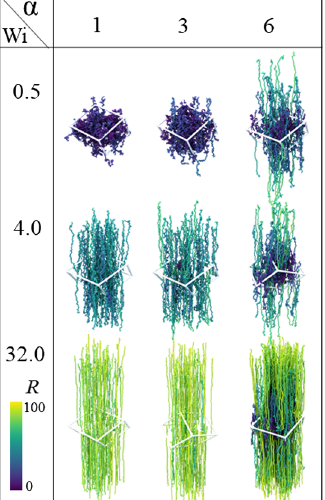
FIG. 1. Snapshots illustrating chain stretching for associating group strength α ¼ 1 , 3, and 6 for Wi ¼ 0 . 5 , 4, and 32 at strain ε ¼ 10 . For clarity, 1 = 4 of systems are shown. Chains are colored according to their end-to-end distance R